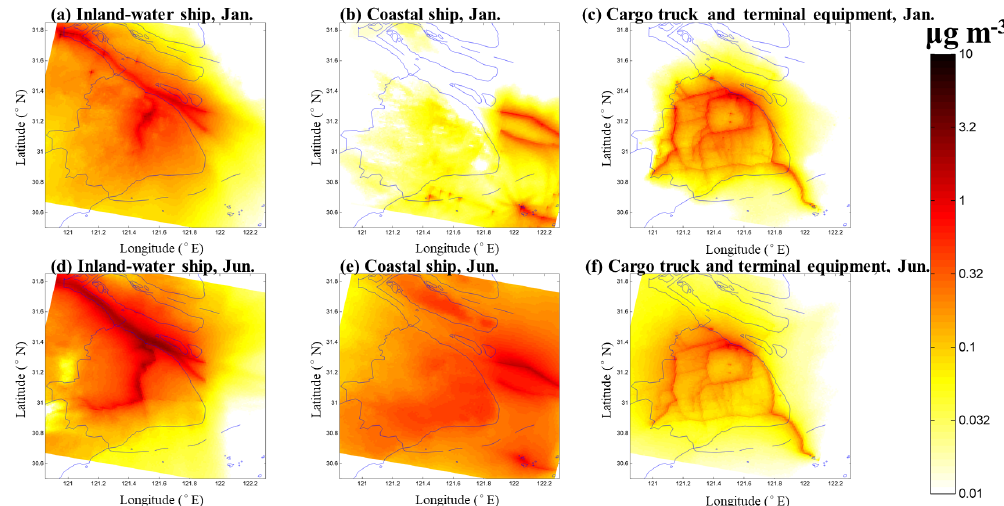
Figure 6. Contributions to PM 2 . 5 concentrations from inland-water ships (a, d) , coastal ships (b, e) , and cargo trucks and port terminal equipment (c, f) in January 2015 (a–c) and June 2015 (d–f)